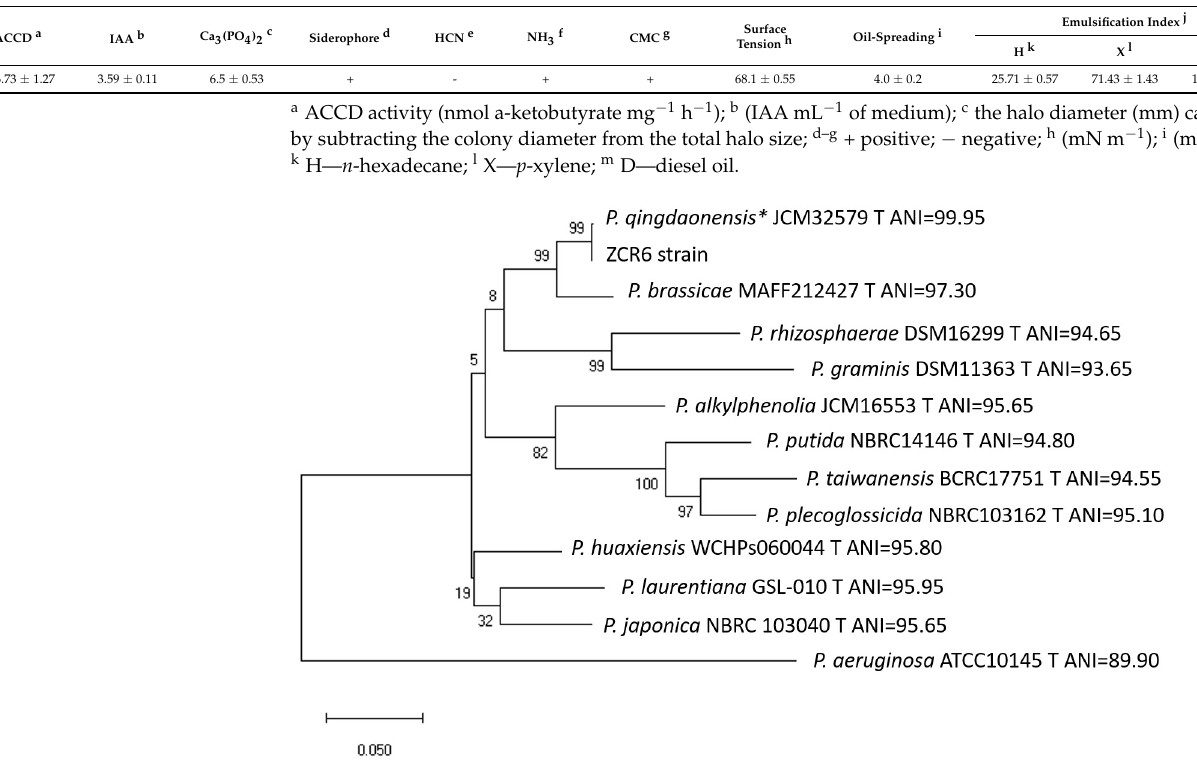
Table 1. The activity of the plant-growth-promoting mechanisms and surface-active abilities of the ZCR6 strain.